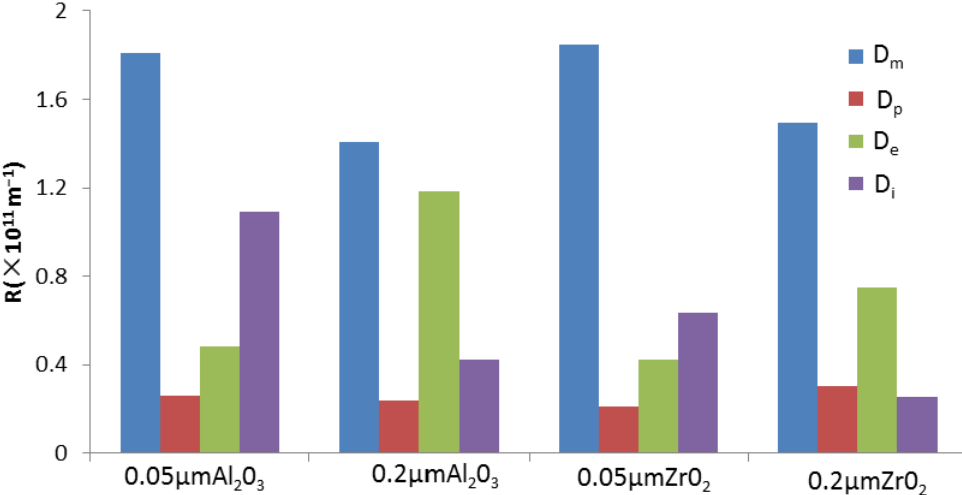
and Al O ceramic 2 2 3